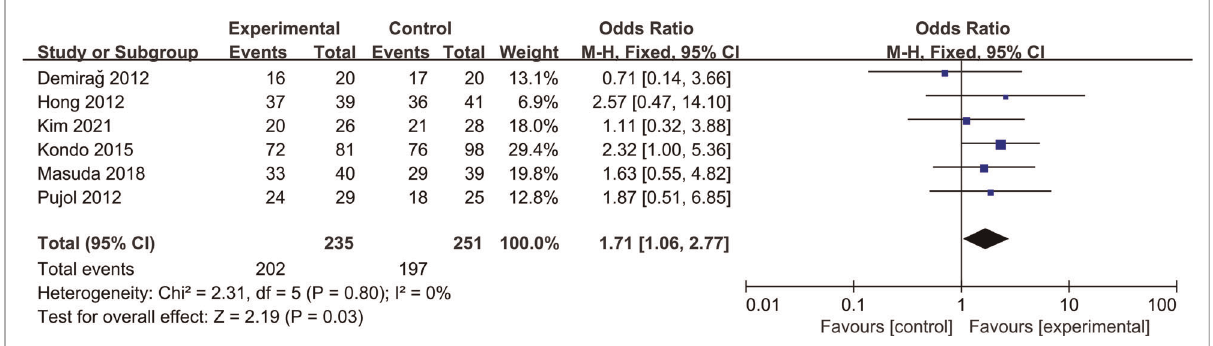
FIGURE 8 Forest pot for Pivot-shift test.